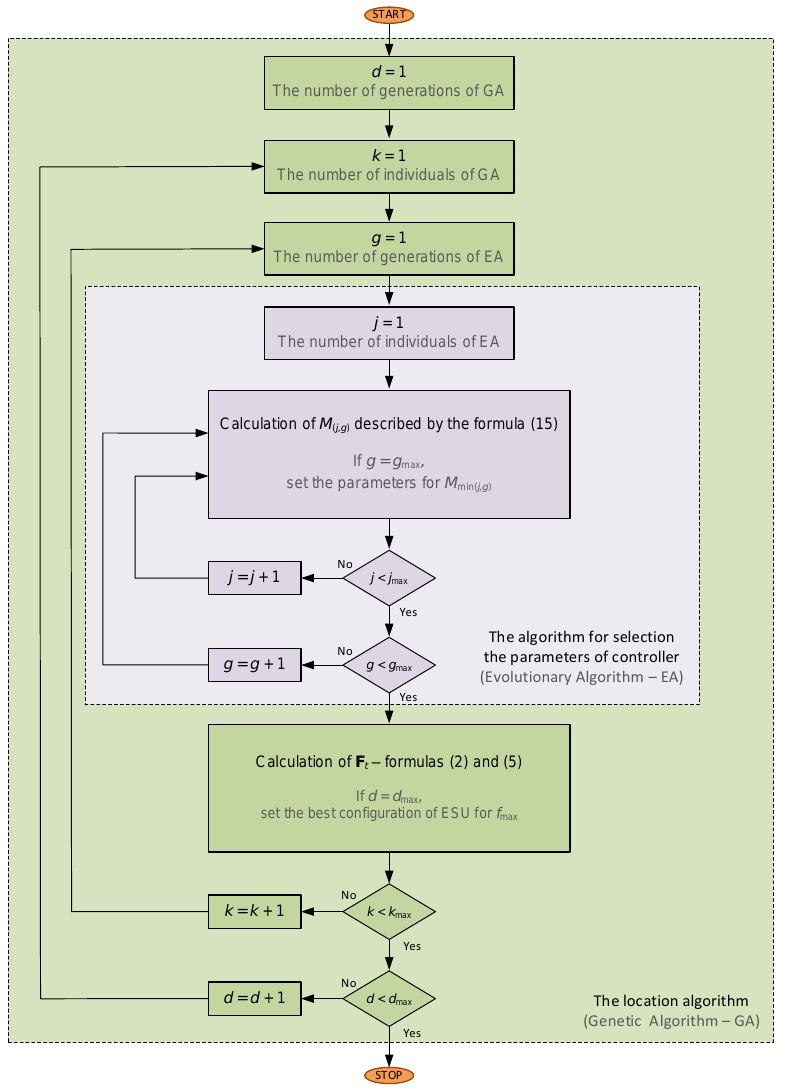
Figure 7. An integrated algorithm for selection of the location and control of ESU (for symbols see Appendix A).